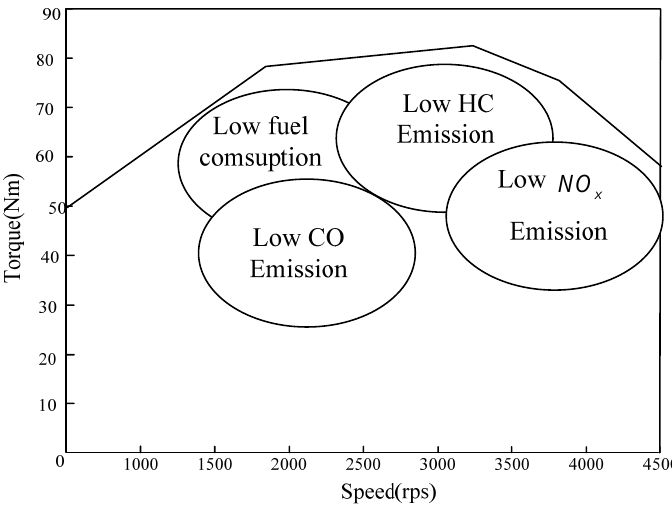
Figure 2. Operating points for an IC engine.